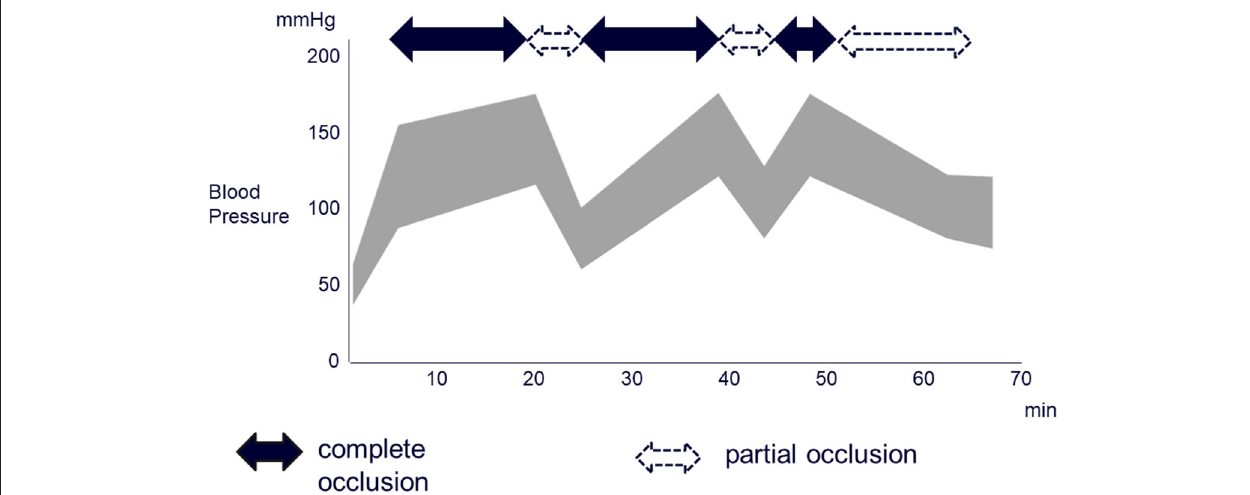
FIGURE 3 | Changes in blood pressure over time after the patient were moved to the fluoroscopy room and the REBOA device was placed. In the complete and incomplete occlusions, balloon inflation volumes of REBOA were 25 and 15mL,